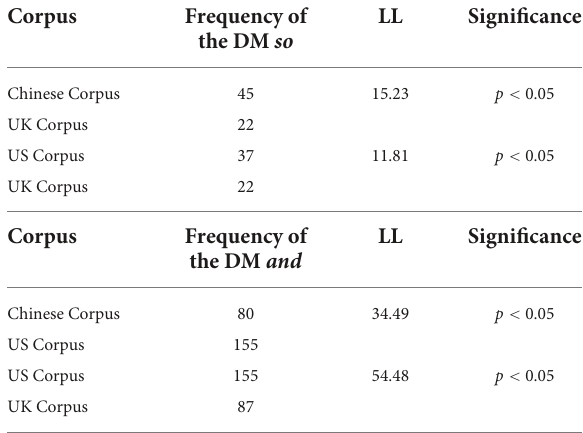
TABLE 6 The frequency comparison of the DM so, and between the